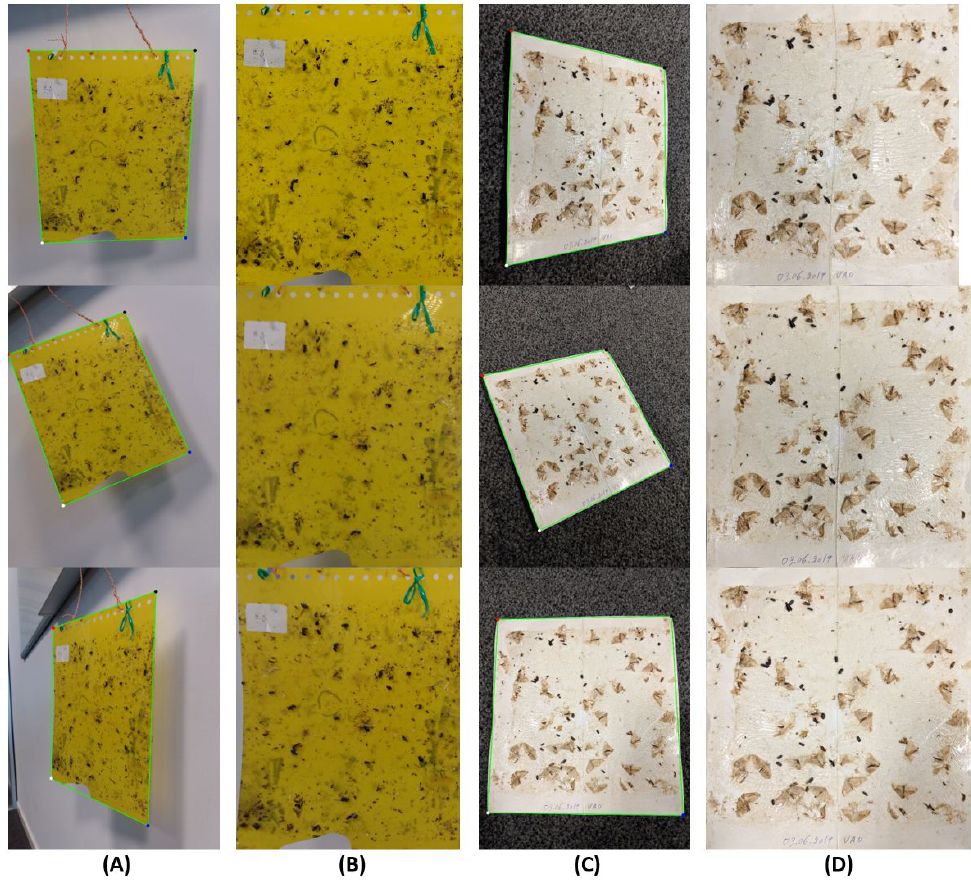
Figure 9. Examples of perspective correction results: CT ( A ) and DT ( C ) images from the same trap, with overlapped corners from the polygonal approximation process; Respective perspective correction results for CT ( B ) and DT ( D )